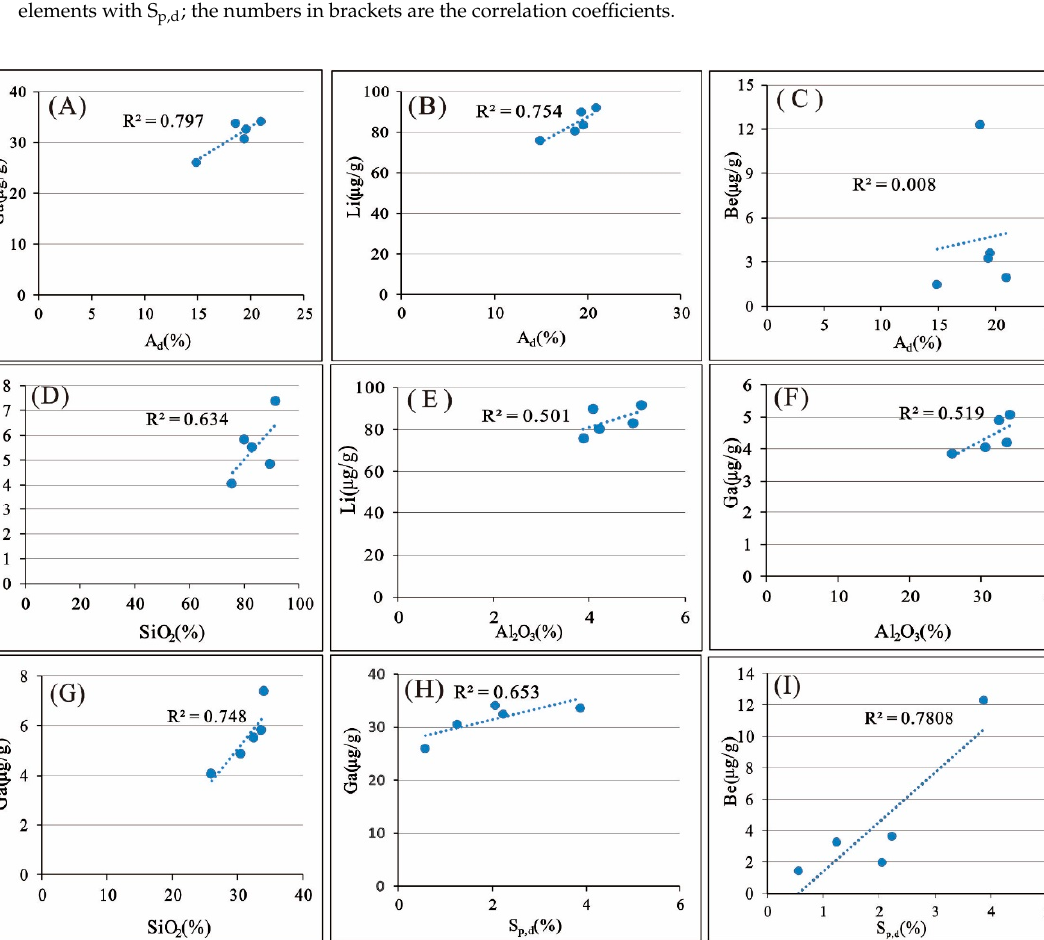
Figure 14. Variations in the ash yield, Li, Bi, Th, Zr, and Ta throughout the coal seam in Dongpo Mine.